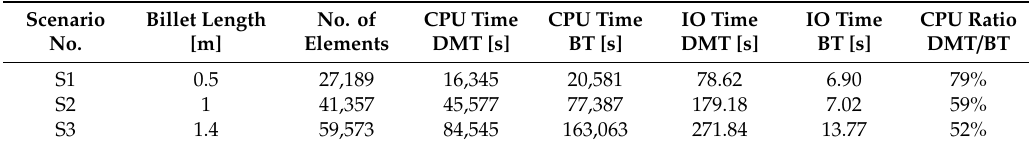
Table 2. Computational scenarios for DMT and BT techniques using a single compute node with 16 cores.